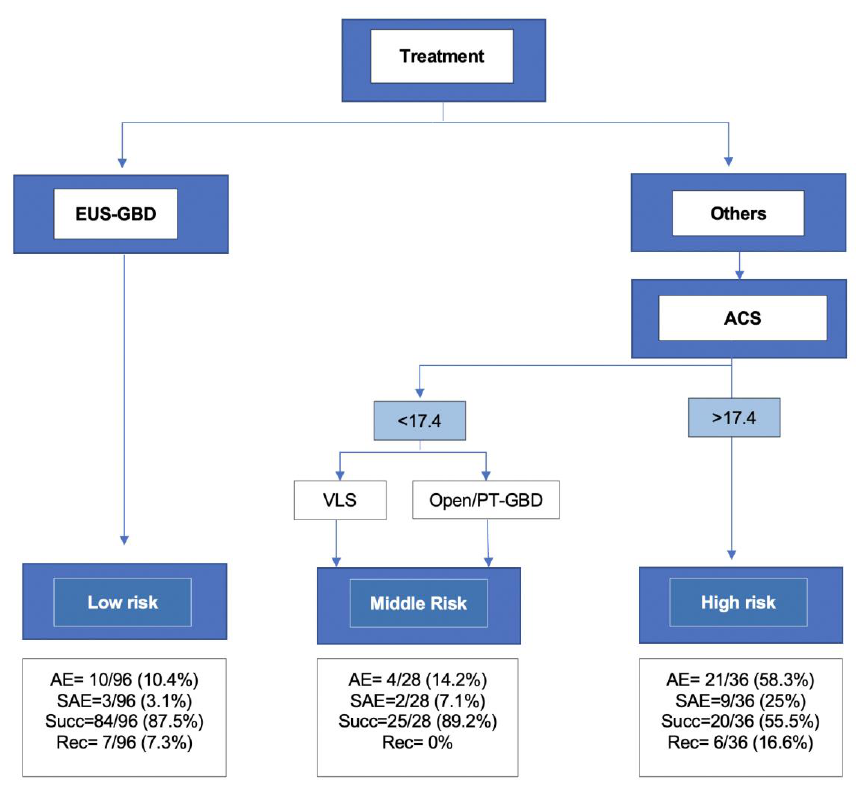
Figure 2. Recursive partitioning classification tree for adverse event occurrence. The terminal nodes categorized the study sample into three prognostic groups according to the adverse event occur- rence rate. Adverse event rate was 10/96 (10.4%) in the low-risk group, 4/28 (14.2%) and 21/36 (58.3%) in the middle and high-risk groups, respectively ( p < 0.001). Abbreviations: VLS: Videolap- aroscopy, PT-GBD: Percutaneous Gallbladder drainage; EUS-GBD: Endoscopic ultrasound guided gallbladder drainage; ACS: American College of Surgeons risk score; AE: Adverse Event; SAE: Se- vere adverse event; Succ: Clinical success (CS); Rec: Recurrence (RR). 3.2. Performance of the Model and Validation The model showed a c-index of 74.3% (95% CI: 71.1%-78.2%; Figure 3) and a proper calibration (Hosmer – Lemeshow p value = 0.58 and mean error rate 3.3%) as shown by the calibration plot (Wald test for calibration slope p = 0.55; Figure 4). The internal validation of the model based on a bootstrap method (250 repetitions), showed a c-index of 72.5% (95% CI 70.3% – 75.4%) (Figure 3) thus excluding the risk of overfitting.